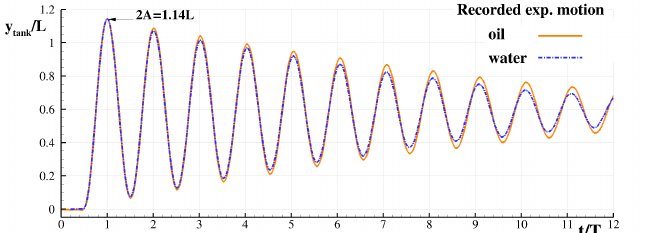
Figure 2. Tank motion recorded in the experiment of [4]: tank with water (dash-dotted line) and tank with oil (solid